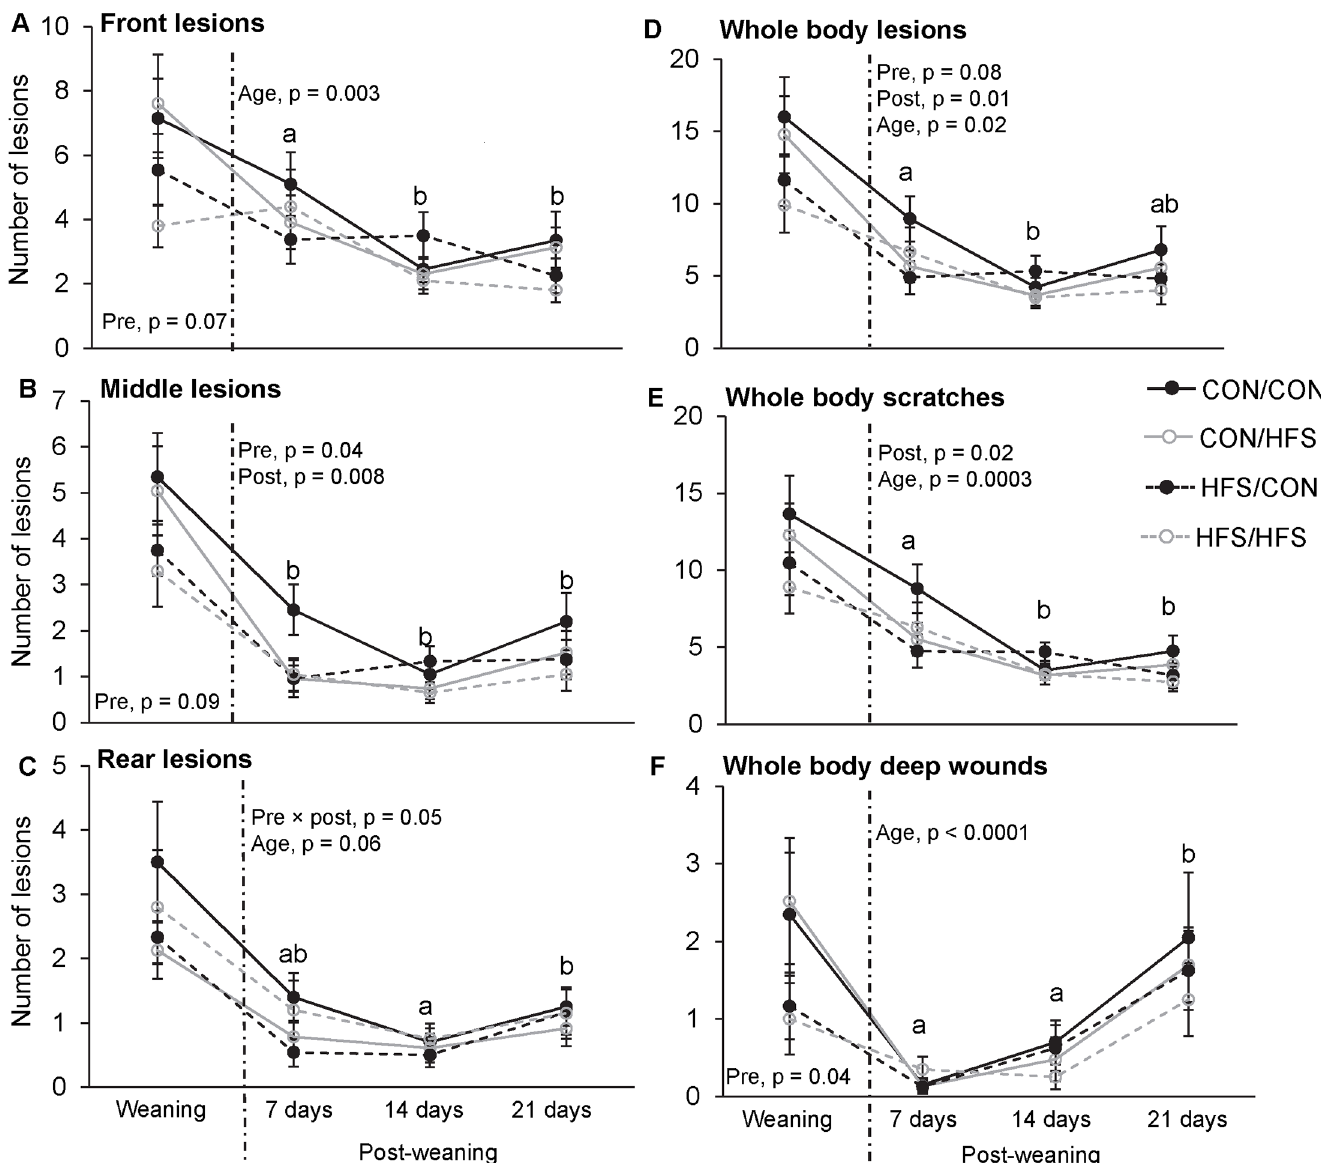
Fig 2. Skin lesions of piglets after weaning. (A) Total lesions, (B) total scratches and (C) total deep wounds on the whole body, and total lesions in the (D) front, (E) middle or (F) rear part of the body. Piglets were exposed to a HFS diet or a control (CON) diet 8 weeks before and/or 8 weeks after birth. Data on the day of weaning (left of the dotted line) were analysed separately from data on 7, 14 and 21 days after weaning (right of the dotted line). Different letters indicate a significant time effect between 7, 14 and 21 days after weaning (p (cid:1)